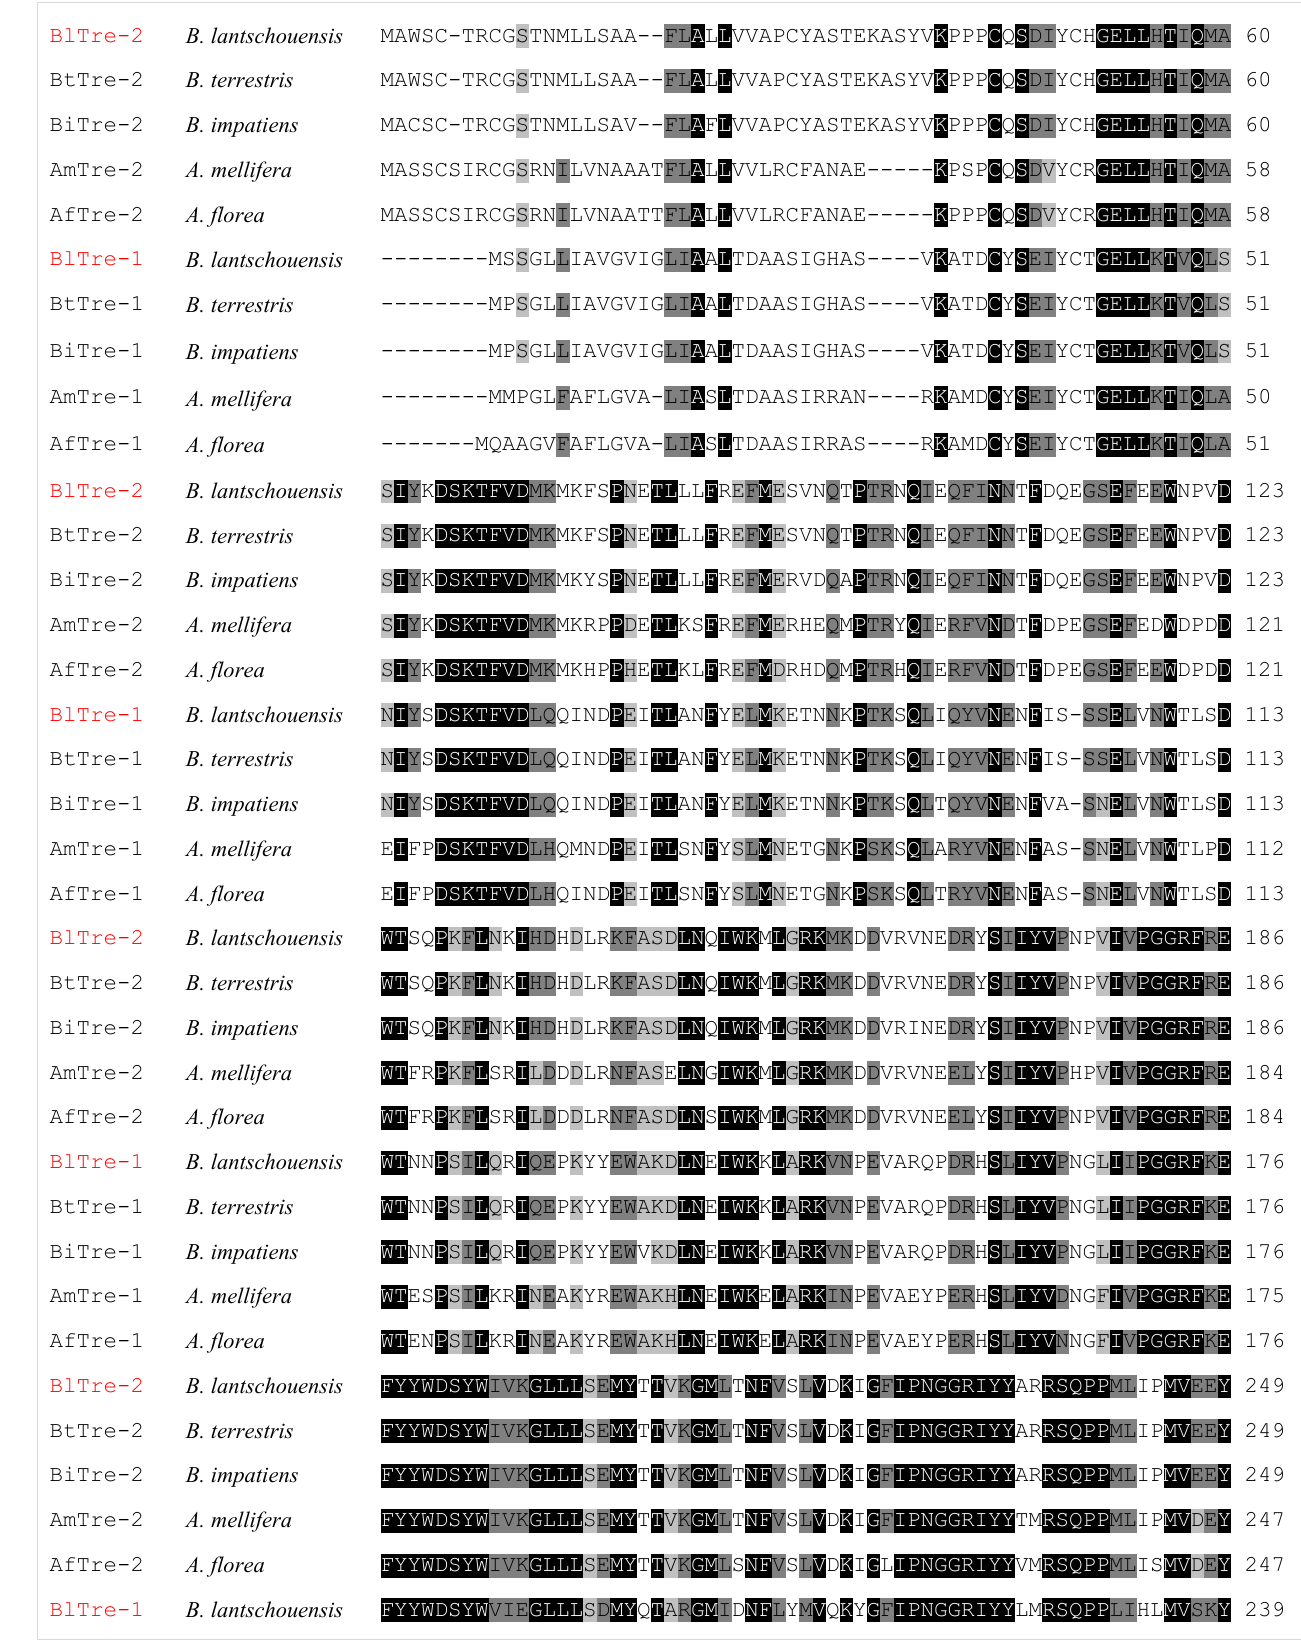
Fig 2 . Comparison of the amino acid sequences of Tre in B. lantschouensis with those in other orthologs. Letters on the left and numbers on the right are the gene names and positions of amino acids on the sequences, respectively. The conserved and similar amino acid residues are labeled in black and gray backgrounds, respectively. The highly conserved glycine-rich regions of trehalase are indicated by a double